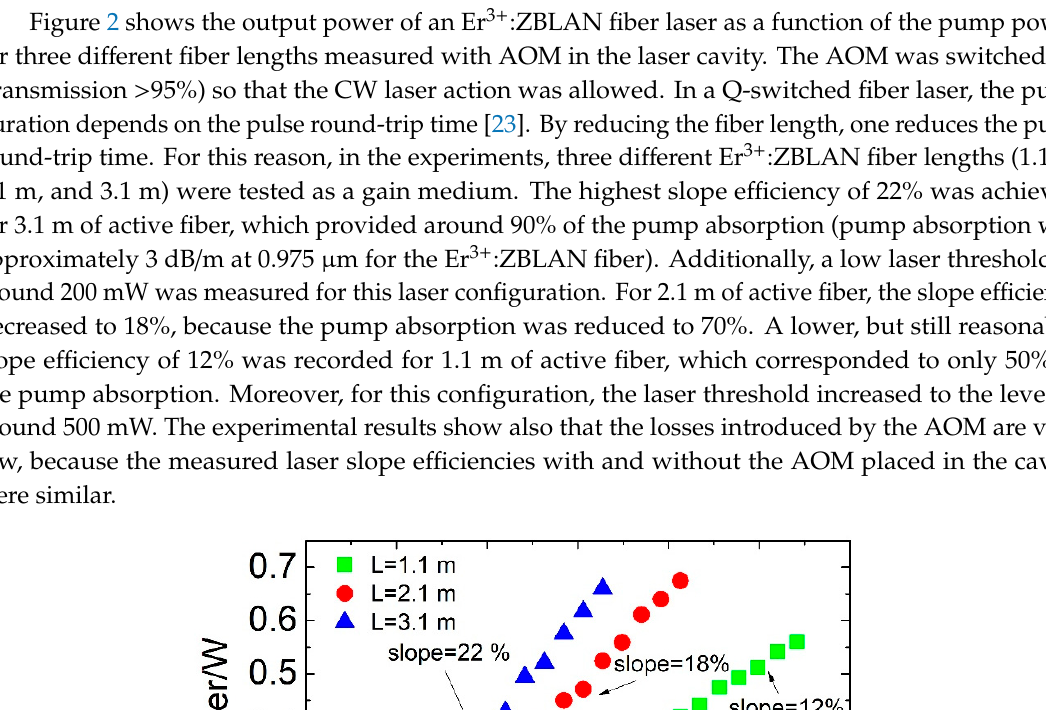
Figure 1. Schematic diagram of the Q-switched mid-infrared fiber laser (HR—highly reflective, HT— highly transmissive, LD—laser diode, AOM—acousto-optic modulator, and CaF 2 —calcium fluoride lens).